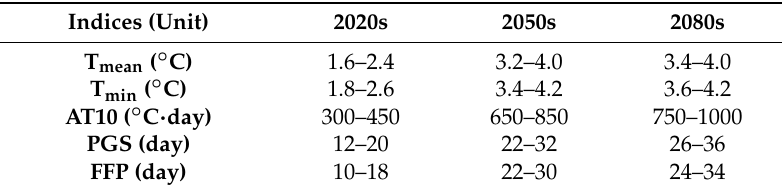
Table 2. Changes of thermal indices during the 21st